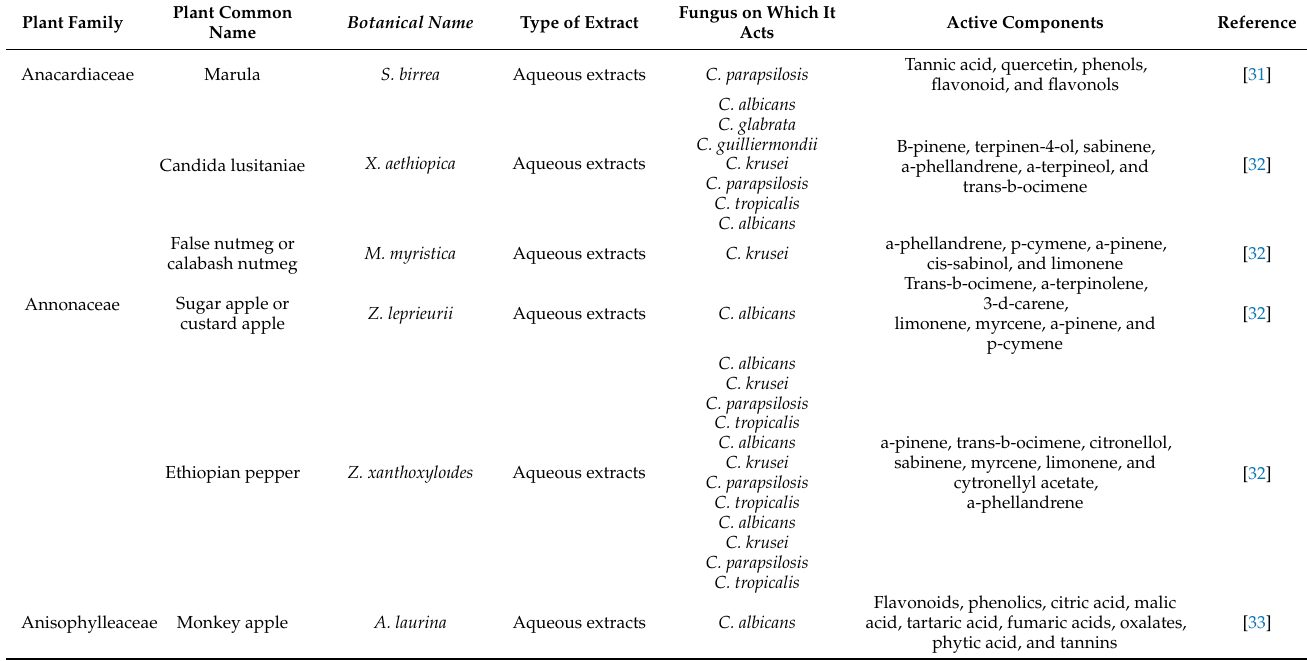
Table 2. Plant species with antimycotic activity for the different species of C. albicans